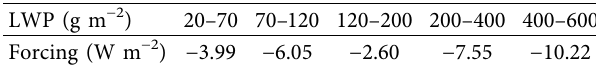
Table 2: Aerosol-mediated shortwave cloud radiative forcing at the SGP site. LWP (g m − 2 ) Forcing (W m − 2 ) −